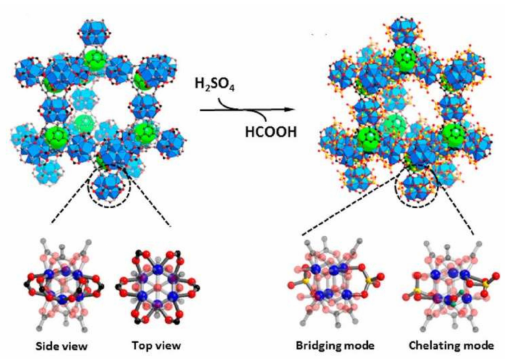
Figure 10. Structure of pristine MOF-808, sulfated S-MOF-808 [82]. Copyright 2019, American Chemical Society.